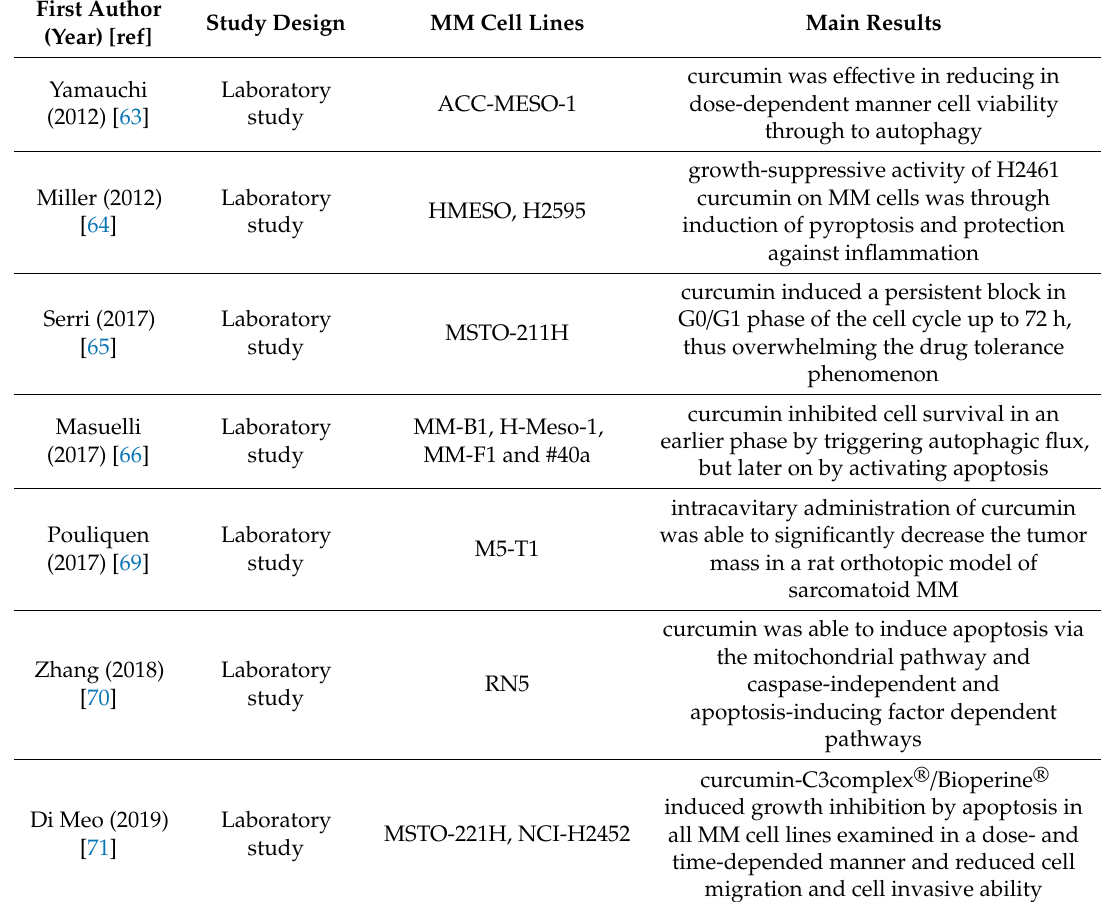
Table 1. Laboratory studies examining the e ff ects of curcumin in